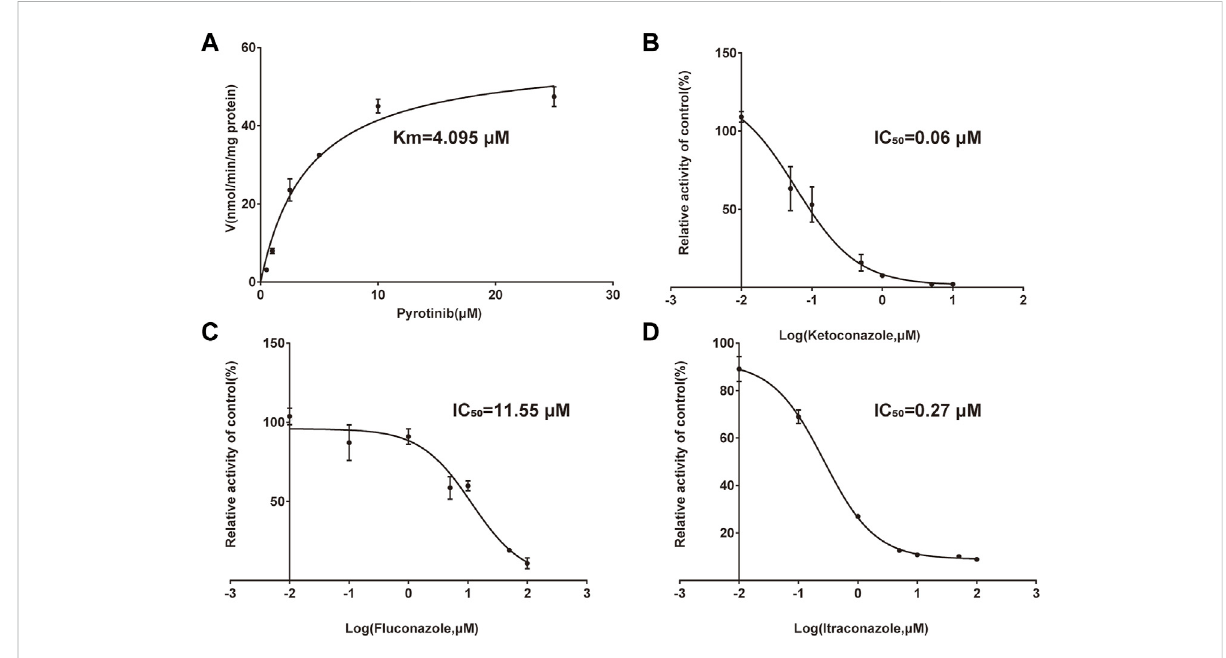
FIGURE 4 The Primary Lineweaver-Burk plots of ketoconazole inhibition on pyrotinib (A) ; Slope of the primary plot of ketoconazole (B) ; Intercept of the primary plot of ketoconazole (C) (values are means ± standard deviations, n =3).